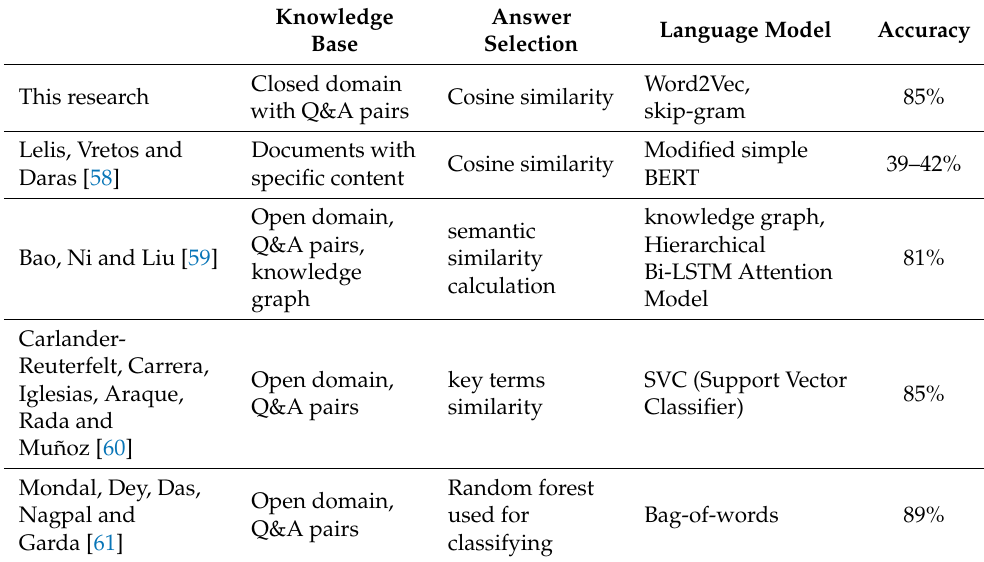
Table 6. Comparison of the proposed system with other Q&A